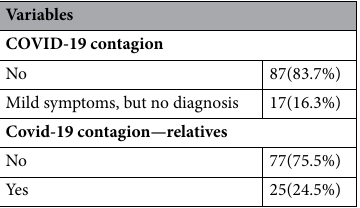
Table 1. COVID-19-related health indicators of the study sample.